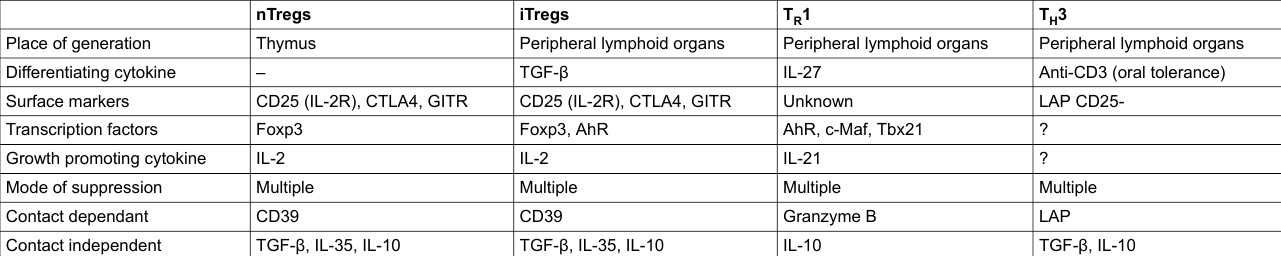
Table 1: Characteristics regulatory T cells. CD4 + regulatory T cells can be divided in natural Foxp3 + Tregs which are generated in the thymus (nTregs) or Tregs generated in the periphery that comprise iFoxp3 + Tregs, T R 1 and T H 3 cells. CTLA4, Cytotoxic T-Lymphocyte Antigen 4; GITR, glucocorticoid-induced TNF receptor family-regulated gene; Tbx21, T-box transcription factor TBX21; LAP, latency- associated